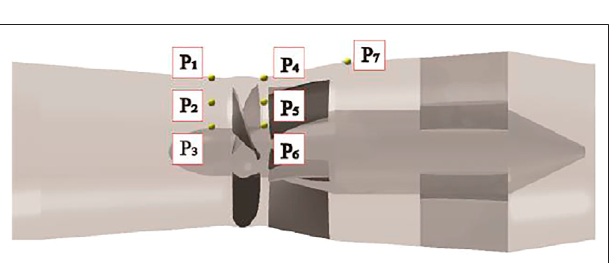
FIGURE 13 | Pressure pulsation monitoring